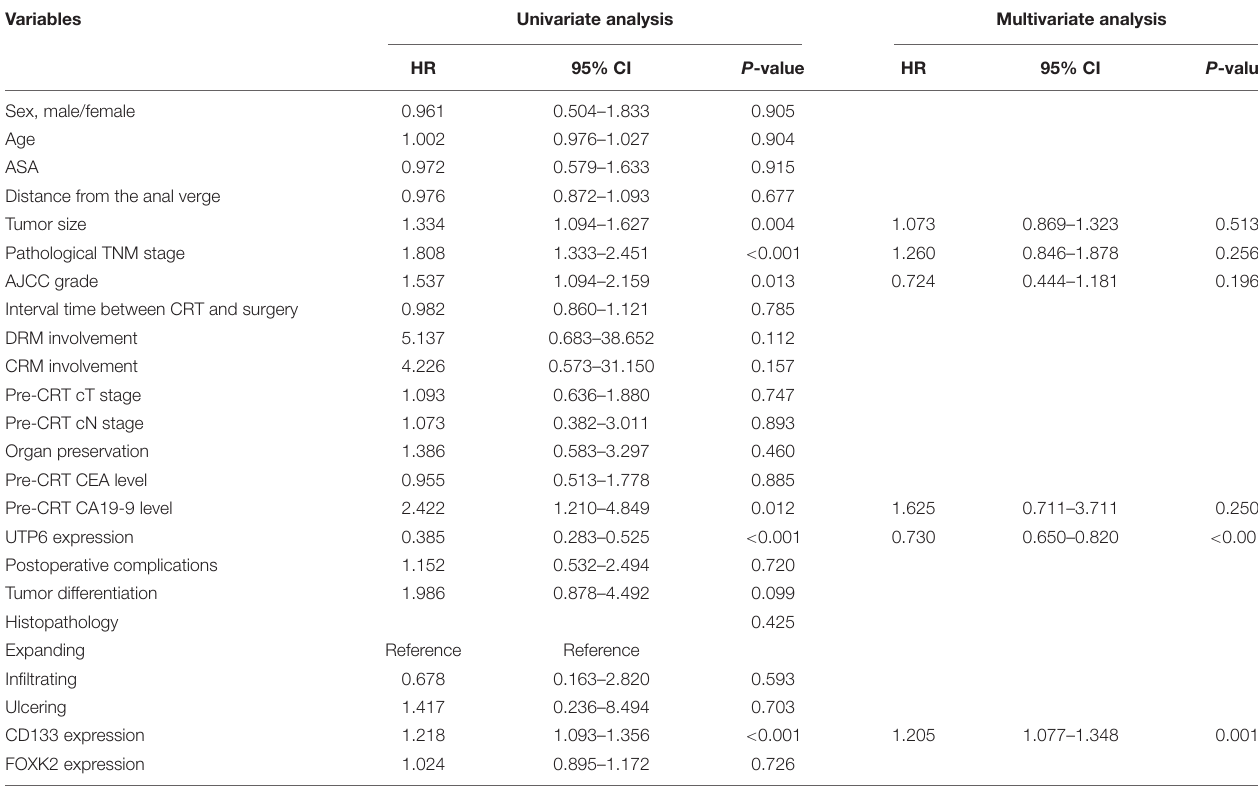
TABLE 2 | Cox regression analysis of predictive factors for disease-free survival in the training dataset patients with LARC following CRT ( n =